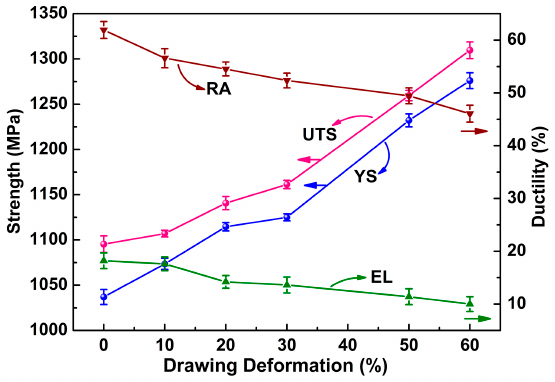
Figure 7. Variation of tensile properties of warm-drawn states as a function of drawing deformation.